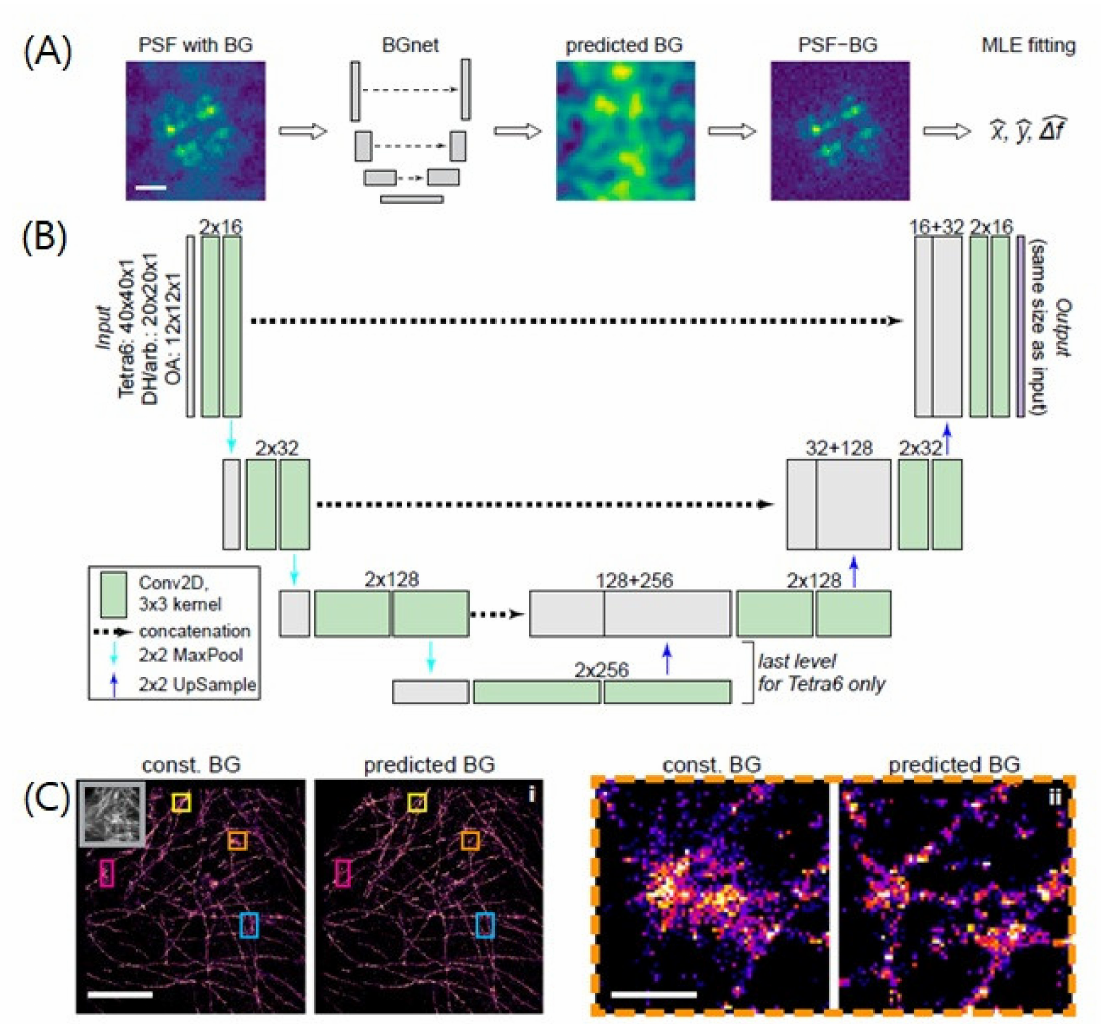
Figure 6. A deep-learning-based method for improving the localization precision. ( A ) The entire process of BGnet. The predicted BG can be readily subtracted from the input PSF image by BGnet and it is used to generate the BG-corrected PSF for subsequent analysis, for example via MLE fitting for position estimation. Scale bar: 1 µ m. ( B ) Network architecture of BGnet. ( C ) (Left) Super-resolution images of microtubules in fixed BSC-1 cells using the BG correction with a constant BG estimate or with BGnet. (Right) The magnified images of the boxed region are shown on the right. Scale bars: 5 µ m for the left images and 500 nm for the right images. Adapted from the article of [37] under Creative Commons Attribution (CC BY)